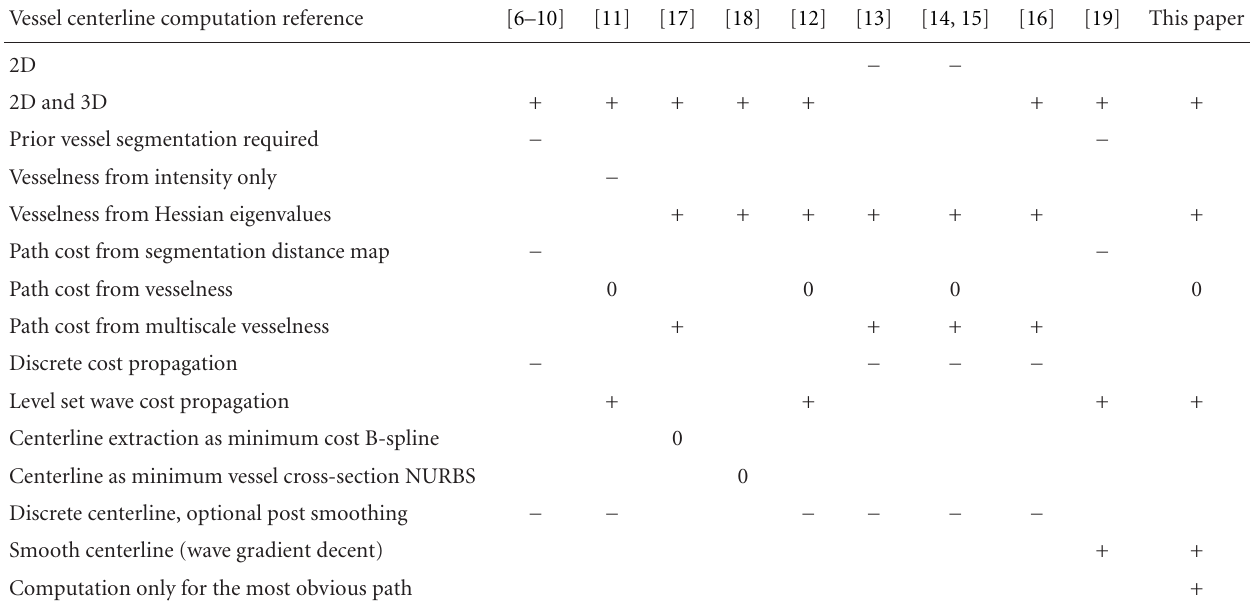
Table 1: Comparison of ideas used in various vessel centerline computation methods. “+” stands for the best idea within a group, “0” for average, and “ − ” for the least desirable idea in a